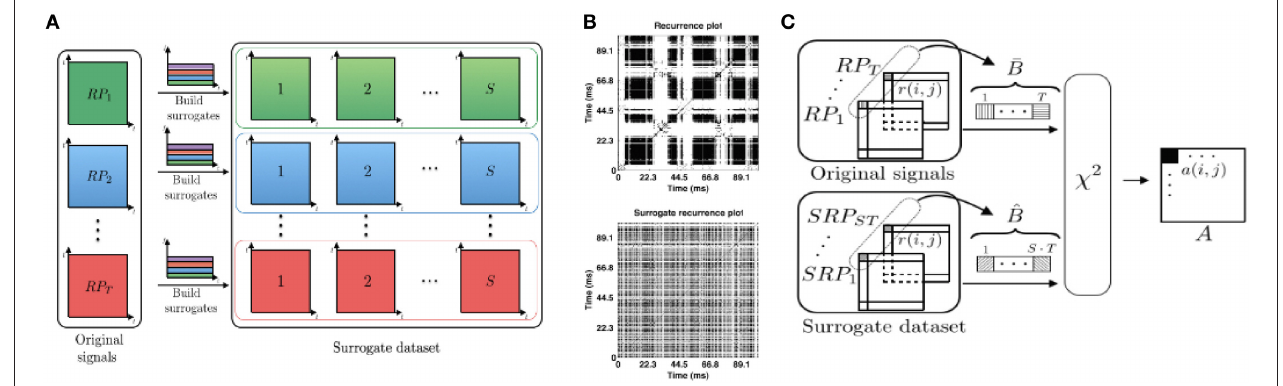
FIGURE 2 | (A) Surrogate set construction: for each of T time-frequency signal representations used for computing the original set of RPs, one computes S surrogate RPs. The resulting S surrogate recurrence plots have the same energy in time-frequency domain. In total, there are S the surrogate RP (bottom) for the transient oscillations dataset. (C) Illustration of the pixel-wise χ 2 statistical test, more details in the text.